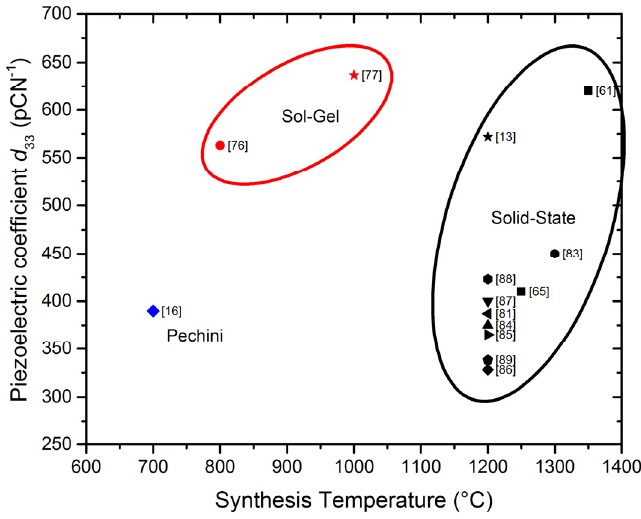
Figure 9. Piezoelectric coefficient d 33 vs . synthesis temperature for the different methods of BCTZ ceramics preparation, extracted from references in Table 1.